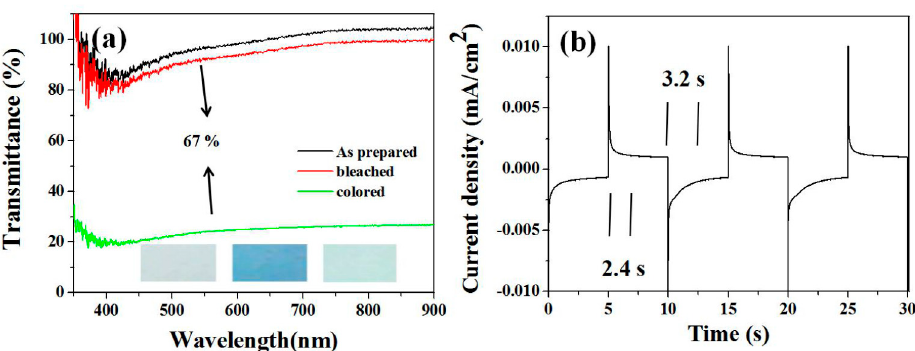
Figure 5. Cyclic voltammograms of MoO 3 nanorod electrodes at a scanning rate of 10 mV/s ( a ) in the potential range of − 2 to +2 V and the optical transmittance spectra of MoO 3 nanorods in the colored and bleached states. The inset images are the photographs of as-prepared MoO 3 and the MoO 3 nanorod film in the colored and bleached states. ( b ) Chronoamperometric curve of the MoO 3 nanorods film.